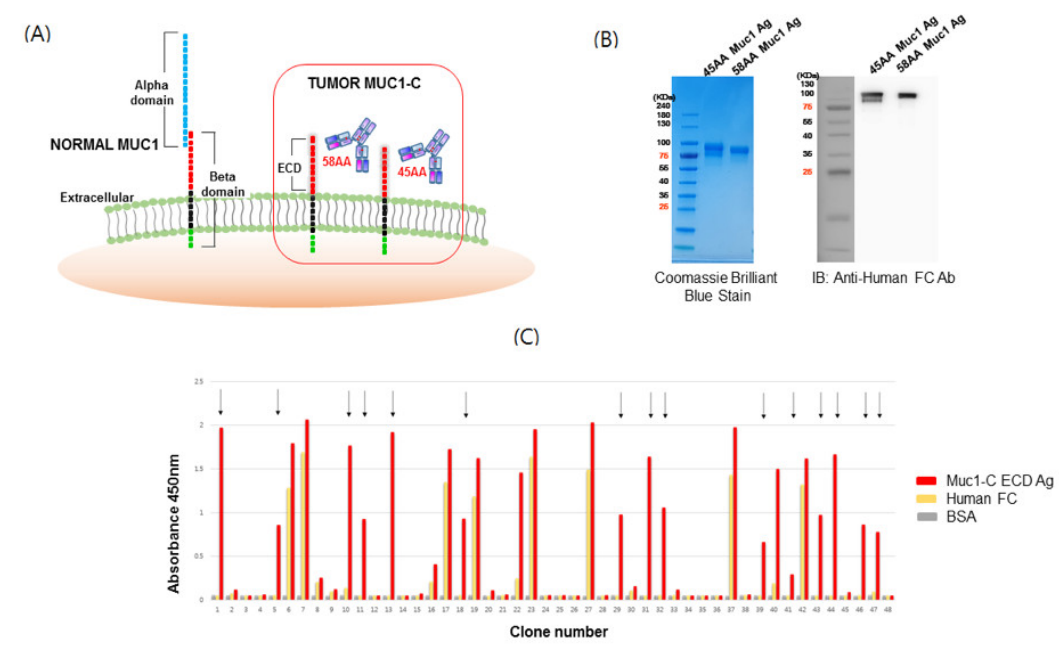
Figure 1. Structure of mucin1 (MUC1) and isolation of scFv clones for the MUC1-C target antigen. ( A ) Schematic structure of MUC1 and potential binding motifs on the MUC1 extracellular region. MUC1-alpha contains a signal peptide and a variable number tandem repeat (VNTR) region, which is composed of 20 amino acids that are extensively O-glycosylated at the serine and threonine residues. The beta-domain (MUC1-C) consists of an extracellular domain (ECD), transmembrane domain (TM), and cytoplasmic tail (CT) domain. The ECD of MUC1 is cleaved by metalloproteases such as ADAM17 or MMP-MT1 to generate MUC1-C (58 amino acids (AA)) or MUC1-C* (45 AA). ( B ) Purification of MUC1-C and MUC1-C* ECD target antigens. HEK293F cells were transfected with vectors encoding MUC1-C-human Fc and MUC1-C*-human Fc ECD, and after 10 days, the expressed antigens were captured from the culture media using a protein A column and stained with Coomassie brilliant blue followed by Western blot using anti-human Fc Ab. ( C ) ELISA of single-chain variable fragment (scFv) clones selected against MUC1-C ECD. A human naïve scFv antibody library precleared of Fc binders was used for biopanning with the recombinant human MUC1-C antigen. Colonies from the last panning were randomly cultured and their scFv supernatants were tested for antigen binding by ELISA. Arrows indicate scFv clones reactive to human MUC1-C ECD (58 AA) but not Fc. BSA served as a background control.